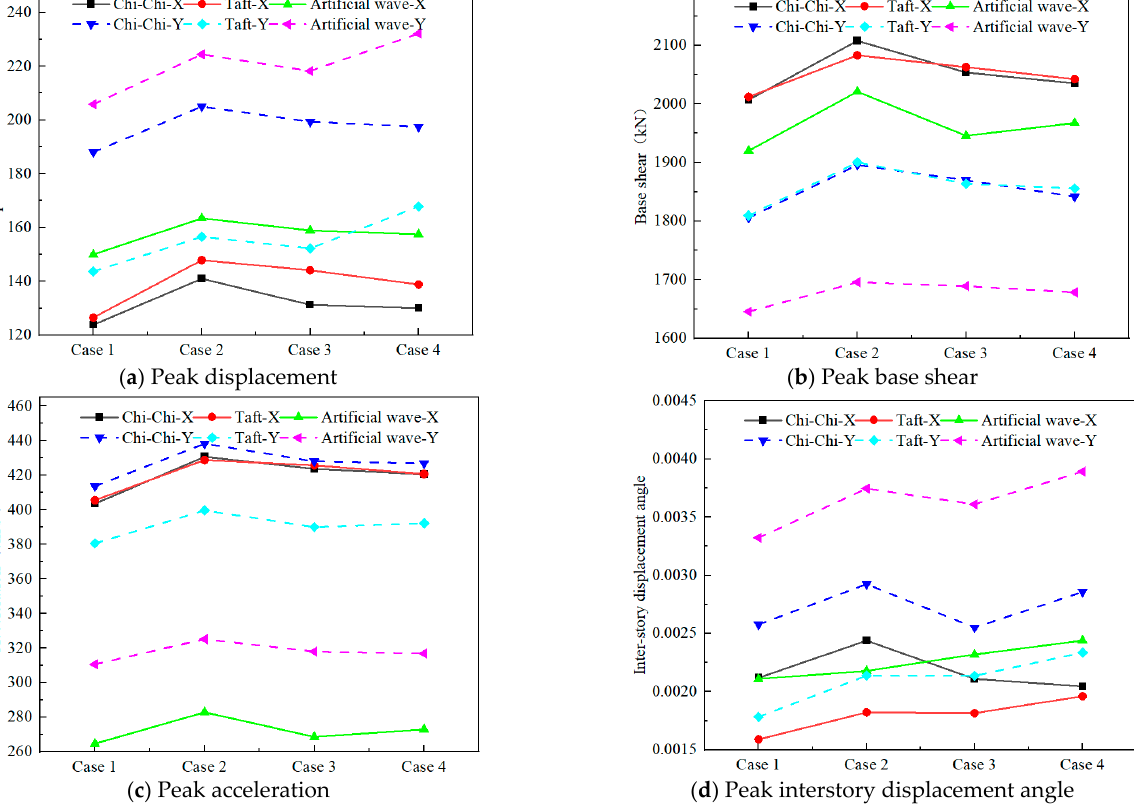
Figure 11. Results of rare-earthquake time-history analysis.